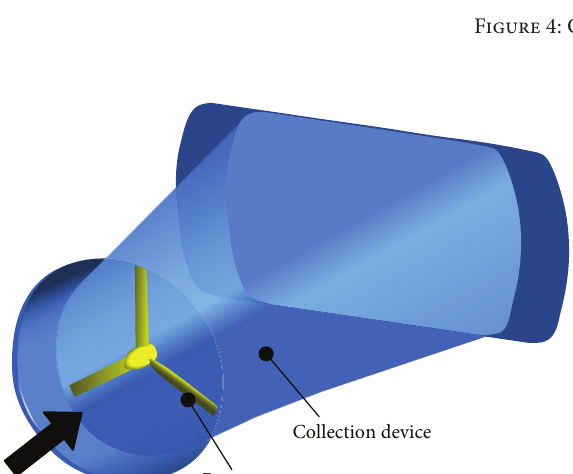
Figure 4: Collection devices.